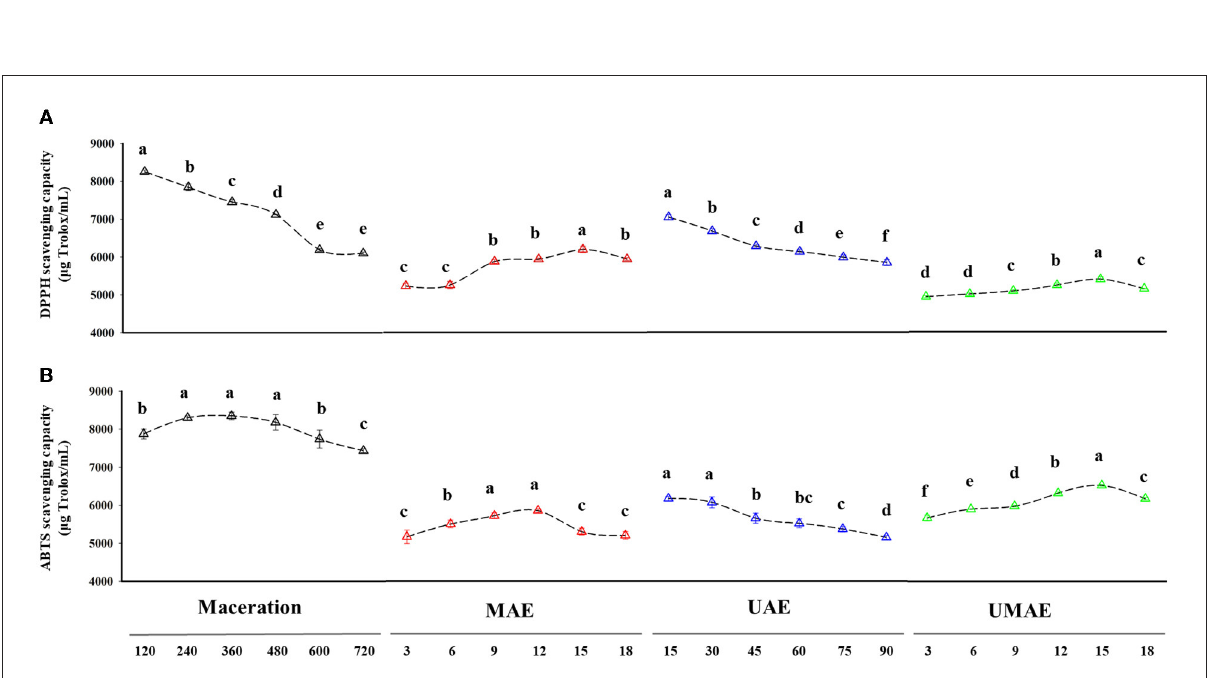
FIGURE3 Antioxidant capacity of oleoresins obtained by different extraction methods. (A) DPPH radical-scavenging capacity. (B) ABTS radical-scavenging capacity. Different letters in the same treatment indicate a statistical difference ( p <